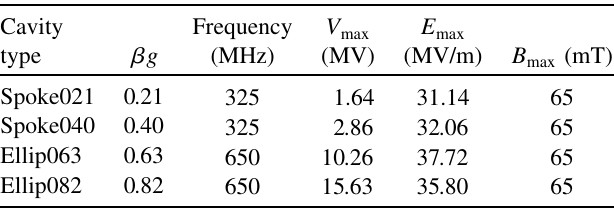
TABLE V. Main parameters of the SC cavities in the main